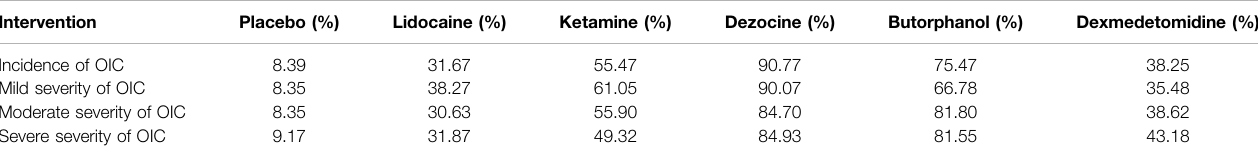
TABLE 2 | Surface under the cumulative ranking curve (SUCRA) probabilities of different drugs for four clinical outcomes. Intervention Placebo (%) Incidence of OIC